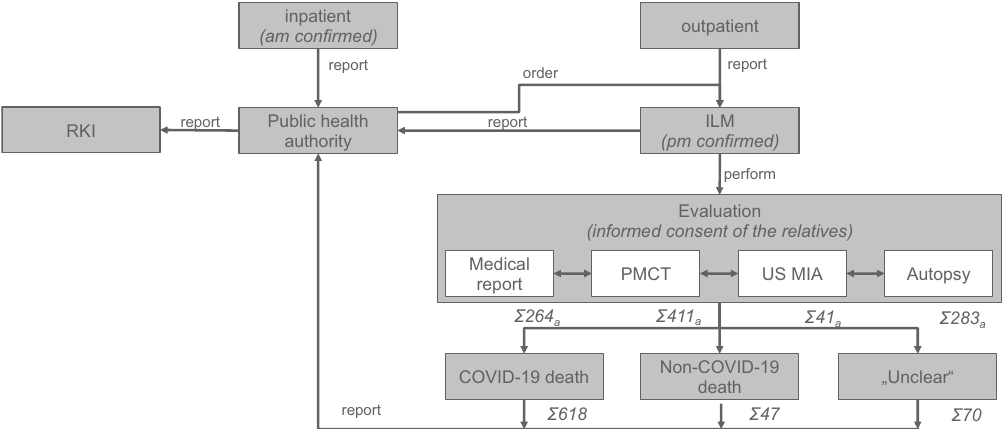
Figure 3. Flow chart of SARS-CoV-2 associated death evaluation at the ILM. This flow chart depicts processes and steps for the evaluation of 735 SARS-CoV-2 associated deaths in cooperation with the Hamburg public health authority. After the evaluation process based on medical report, postmortem computed tomography (PMCT), ultrasound-guided minimally invasive autopsy (usMIA) and conventional autopsy, 618 deaths were classified as COVID-19 deaths, 47 deaths were non-COVID-19 deaths and 70 deaths remained unclear. am antemortem, pm postmortem, ILM Institute of Legal Medicine, RKI Robert Koch Institute; a multiple inclusion of one patient in the various categories